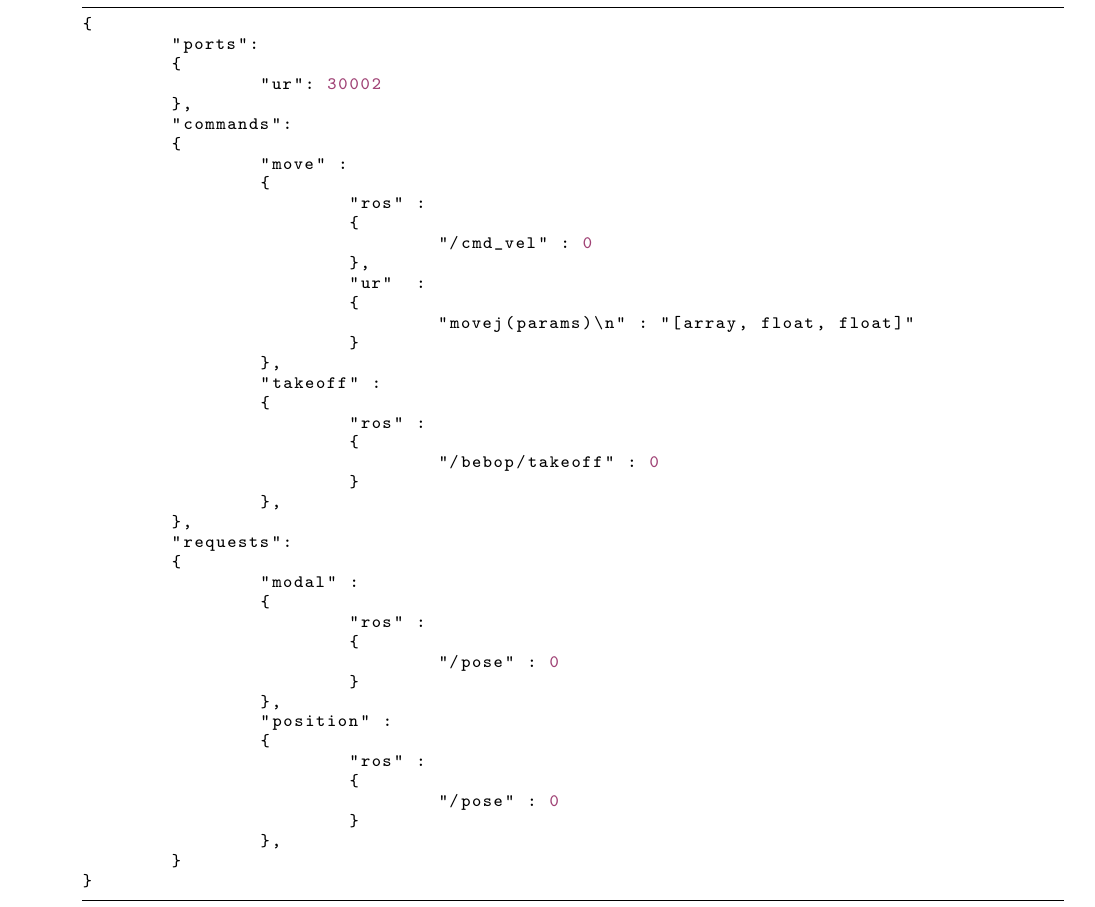
Figure A3. Commands configuration